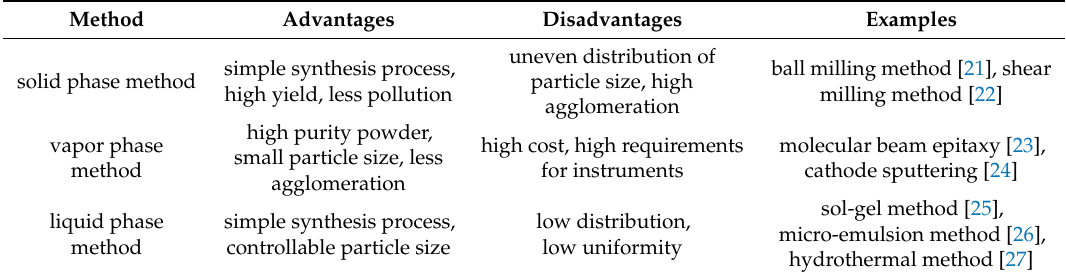
Table 3. The type and characters of preparation methods of